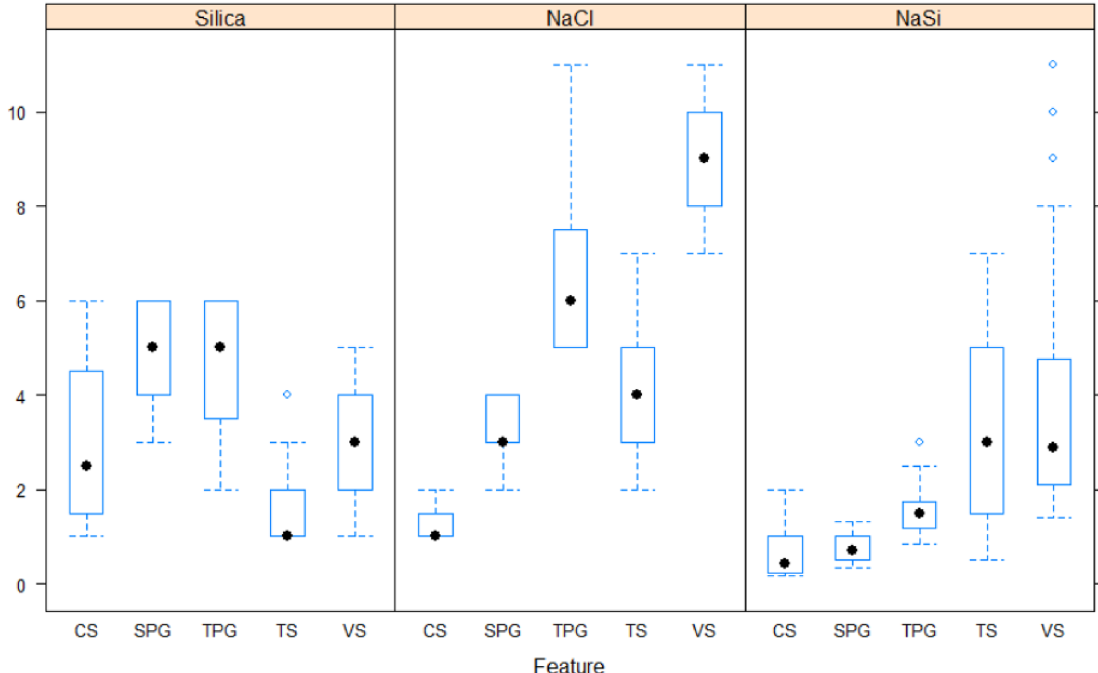
Figure 3. Median ± interquartile range (boxes) and 95% confidence intervals (whiskers) for silica, NaCl, and NaCl/Silica ratio based on different classes observed in bottle tests. CS clear suspension, SPG single-phase gel, TPG Two-phase gel, TS turbid suspension, VS viscous